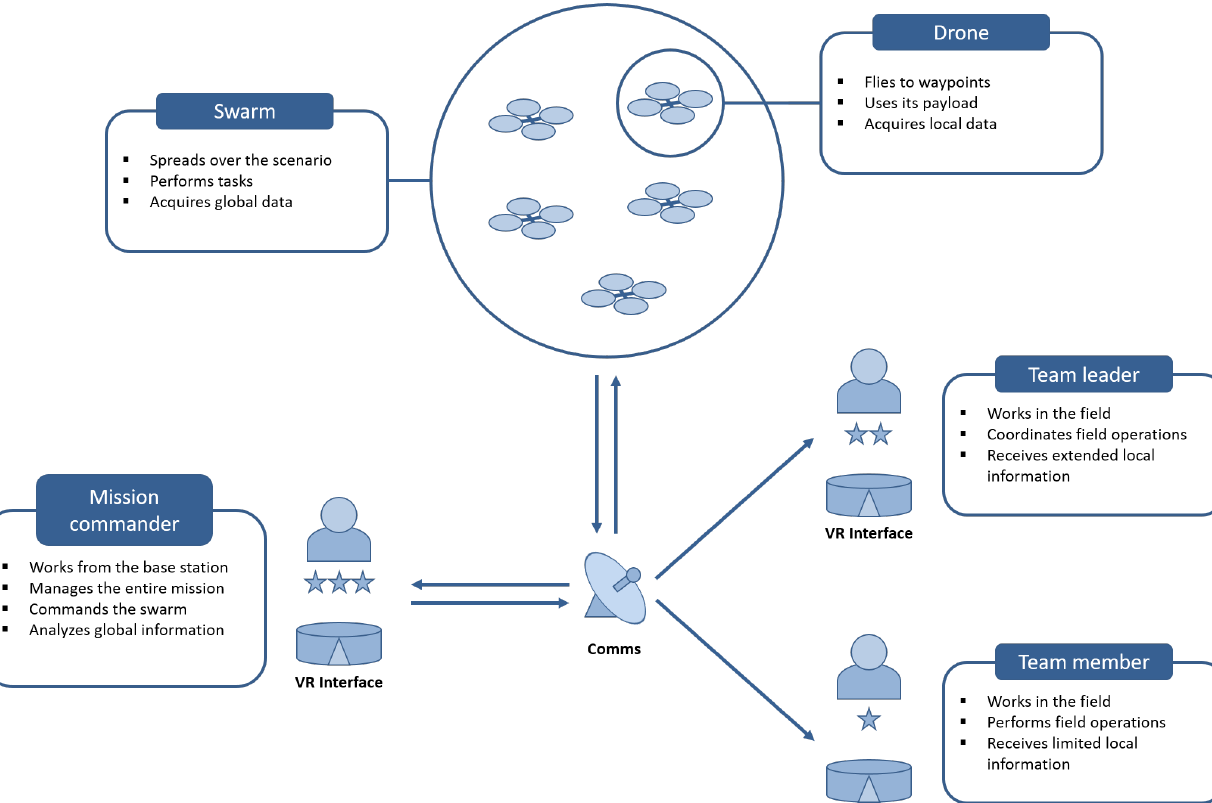
Figure 3. System